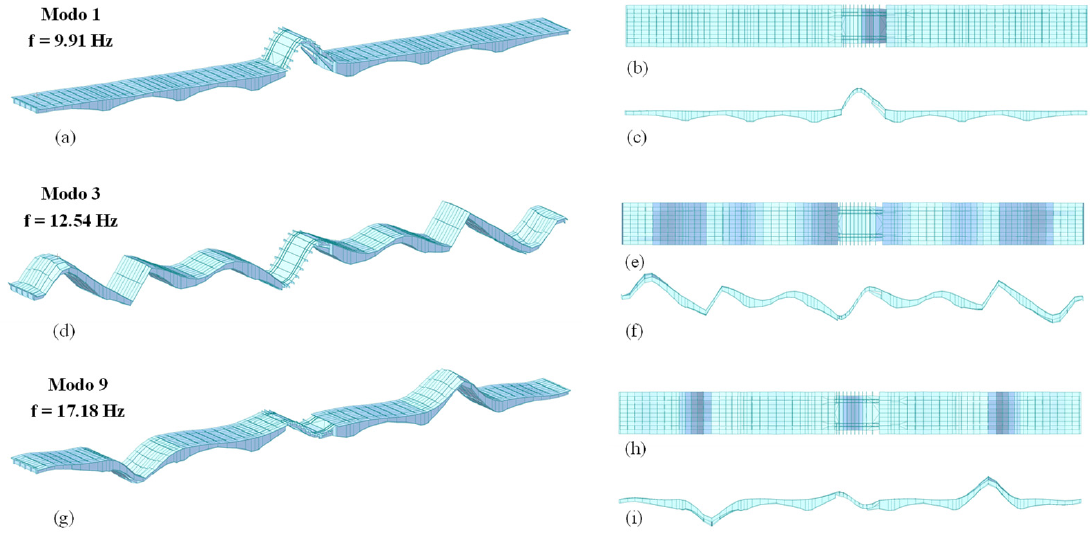
Figure 18. Modal shapes of the updated model: ( a , d , g ) 3D view; ( b , e , h ) view from above; ( c , f , i ) lateral view.